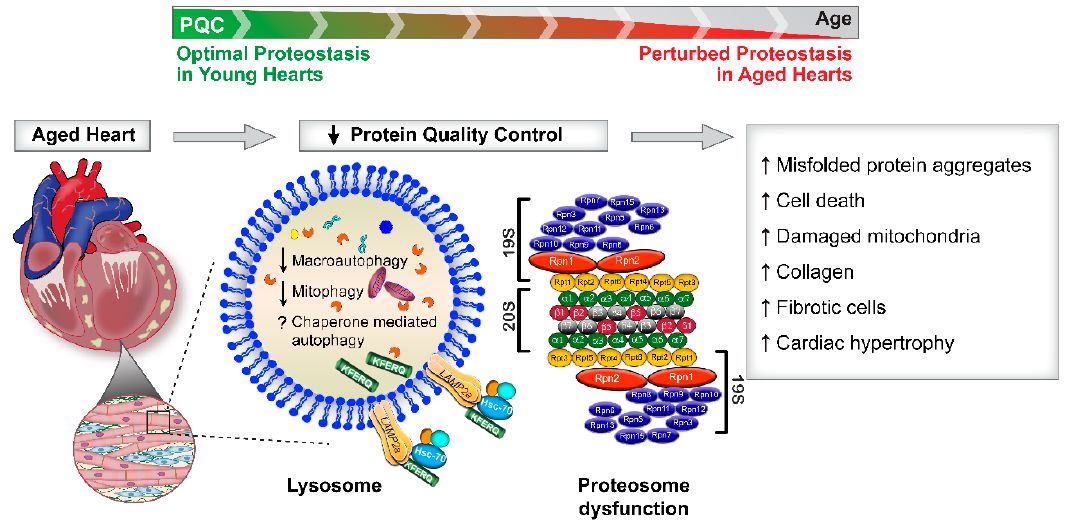
Figure 2. Decline in protein quality control in the aging heart. The heart exhibits a progressive decline in the intracellular protein quality control (PQC) pathways during the aging process. Macroautophagy, mitophagy and chaperone mediated autophagy (CMA) are lysosomal-dependent protein degradation pathways. Strong evidence exists that macroautophagy and mitophagy are decreased in old hearts. At present it is unclear how aging regulates CMA function in the heart. Enzymatic activities of the proteasome are severely reduced in the aging heart. As a consequence of impaired protein quality control, the aging heart accumulates misfolded protein aggregates (proteotoxicity), cell death proteins, and dysfunctional mitochondria. This cardio / proteo-toxic profile is associated with heightened fibrosis, collagen deposition, and cardiac hypertrophy.